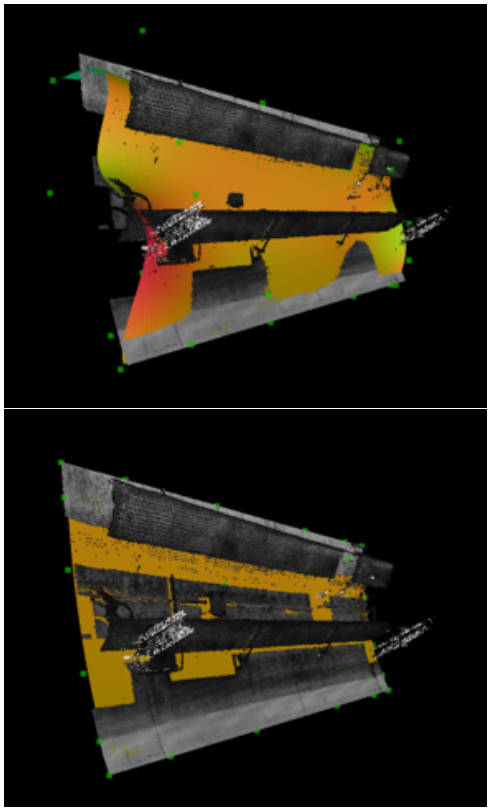
Figure 2. B-spline tunnel surface modeling with LS (top) or robust (bottom) fit. The adjusted surface is shown in brown, superimposed on the 3D data, green squares are control points However, since LS are sensitive to erroneous data, IOoR points as well as foreground objects and artifacts tend to attract the surface and distort it unduly (see the example of LS fit in Fig.